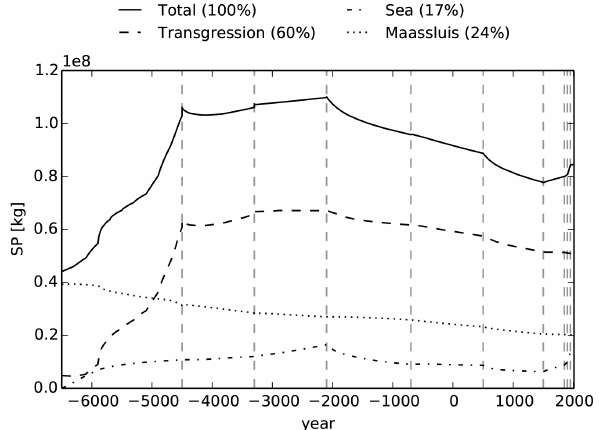
Figure 8. Contribution of transgression, sea, and Maassluis to total salt present (SP). Only the model domain east from x coordinate 95km is considered. Vertical dashed lines denote time-slice tran- sitions, discontinuities at transitions result from changing numbers of active model cells. Legend percentages are percentages at model